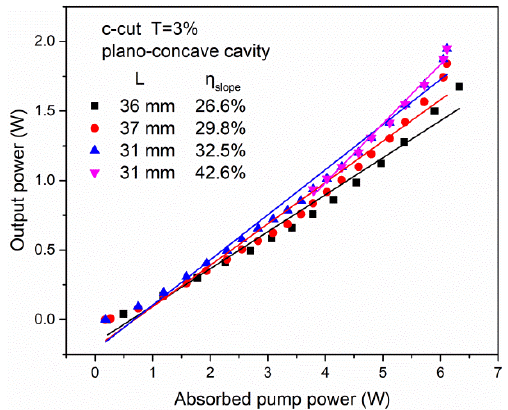
Figure 6. The CW laser characteristics of the Nd:ASL crystal with different cavity lengths along the c-axis.